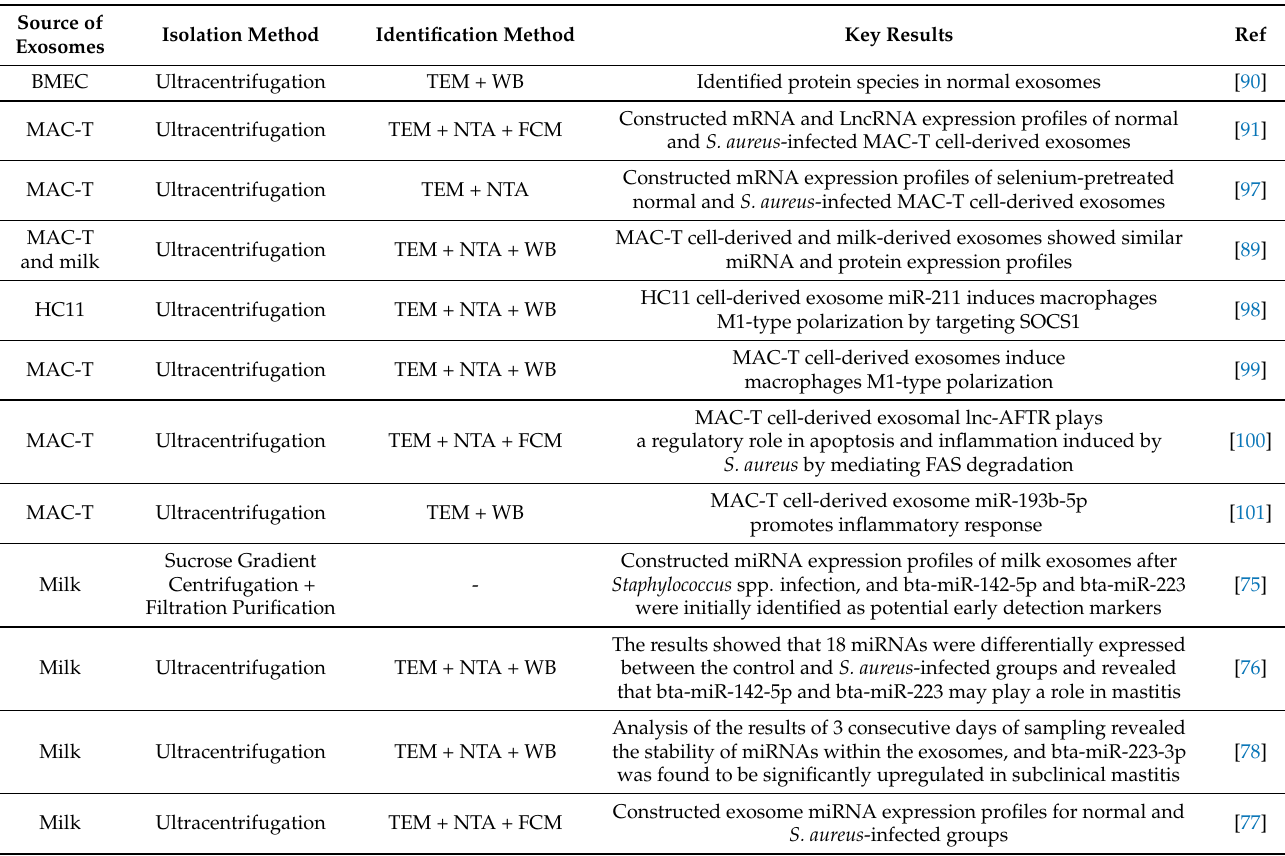
Table 1. Research Status of Exosomes in